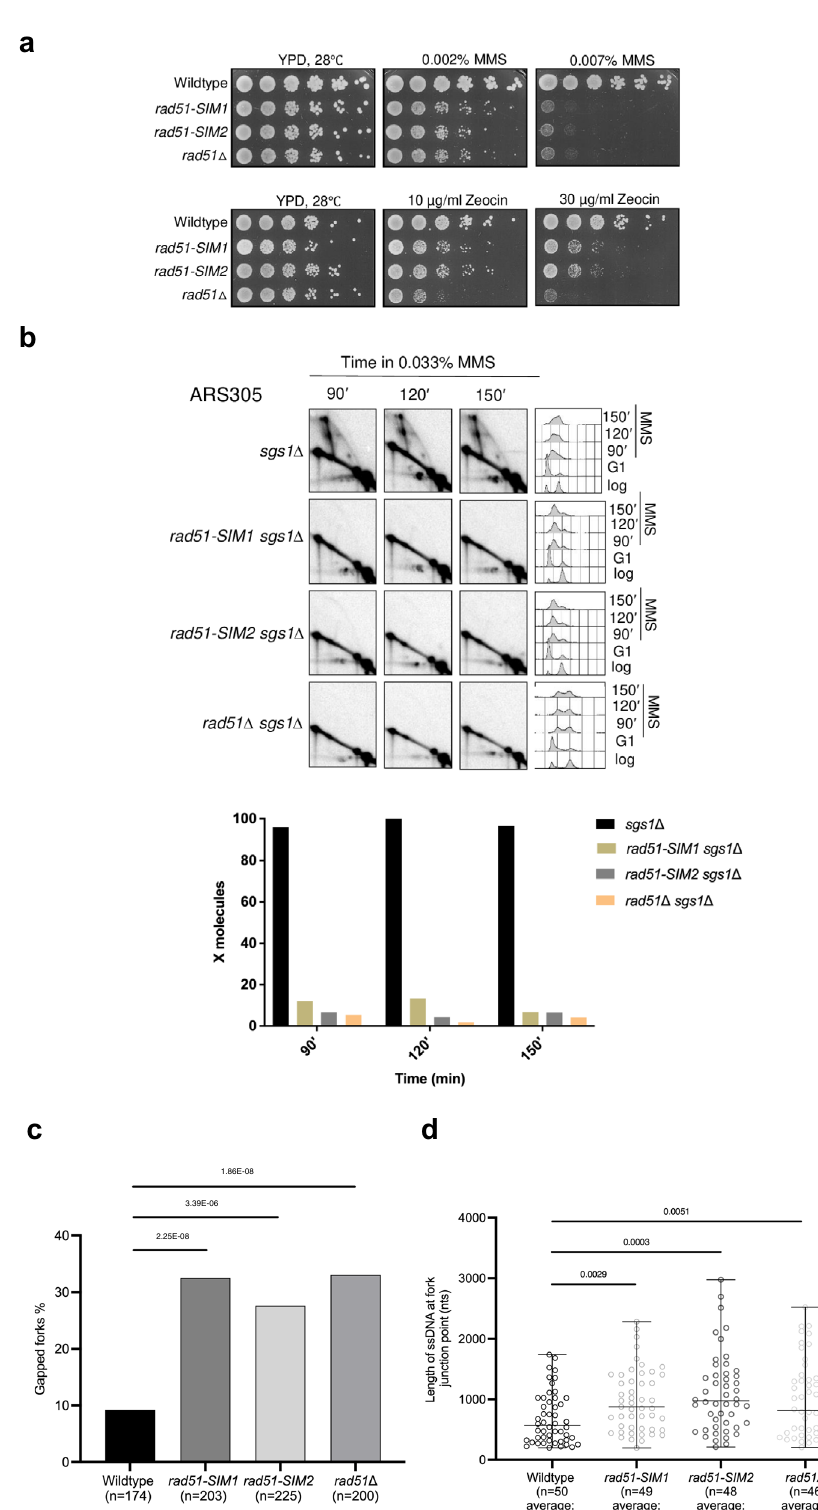
reactions with 0.8mg anti-Rad51 antibody (Santa Cruz, sc 33626) and Dynabeads protein G were allowed to proceed overnight at 4 °C. After washing and eluting the ChIP fractions from beads, crosslinks were reversed at 65 °C overnight for both Input and IP. After proteinase K treatment, DNA was precipitated using sodium acetate (3M) and 100% ethanol. Real-time PCR was performed using QuantiFast SYBR Green PCR kit according to the manufacturer ’ s instructions and each ChIP experiment was repeated 3 times and each qPCR was performed in triplicates using a Roche Light Cycler 96 system and Numbers software as previously reported 37 .